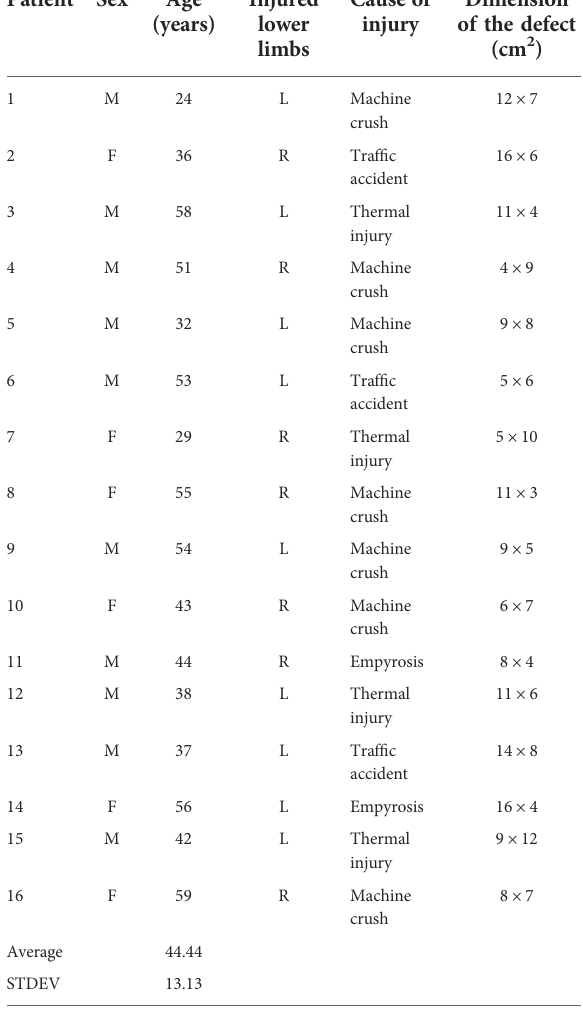
TABLE 1 Patients ’ detail